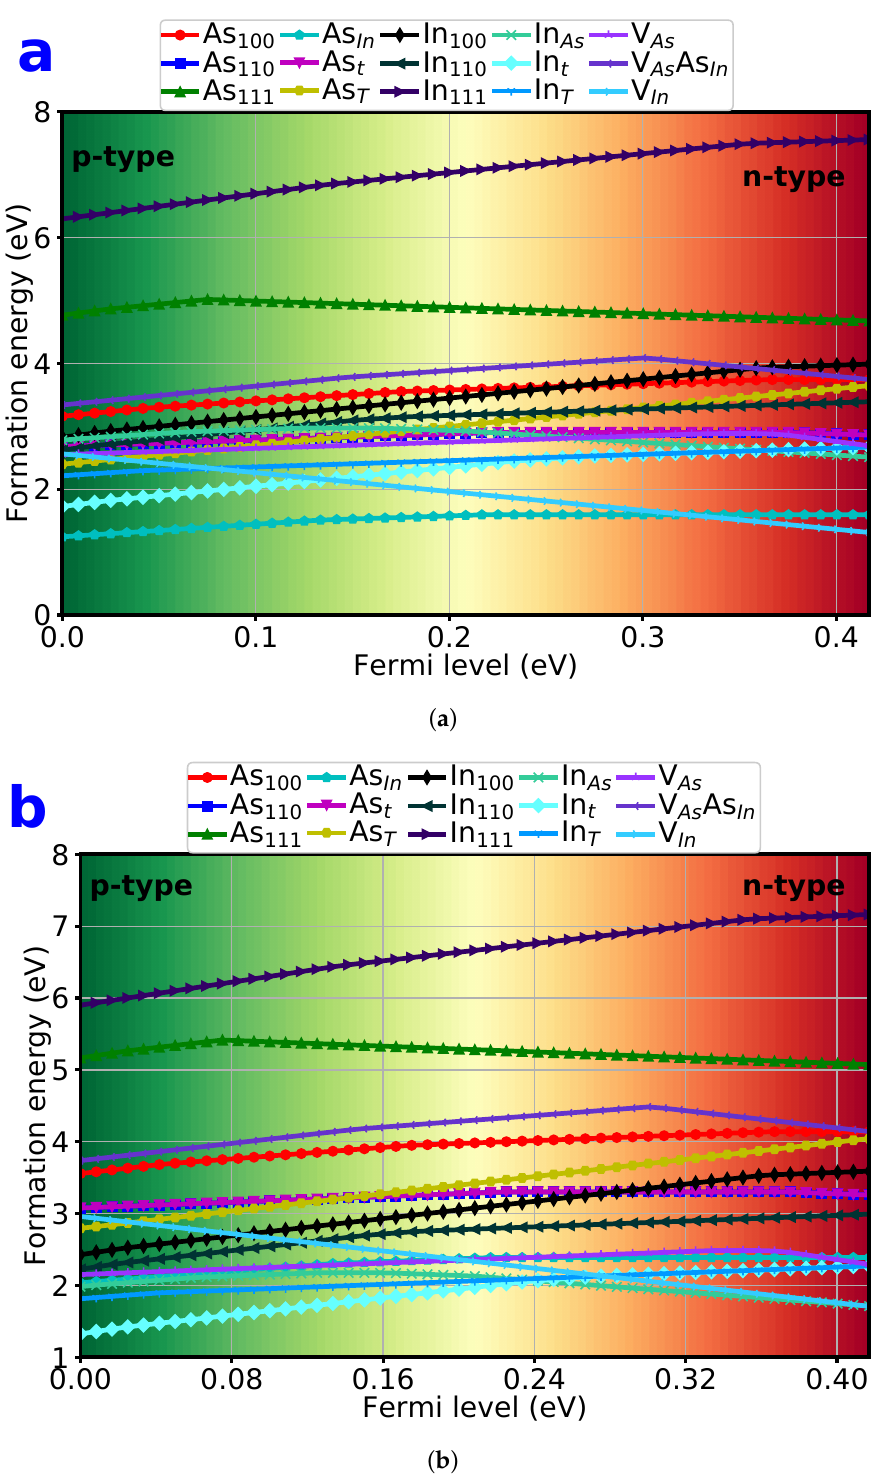
Figure 3. Formation energies as functions of E F in the As-rich ( a ) and In-rich ( b ) environments for fifteen different types of point defects in zb -InAs with all possible charge states from − 4 to +4 + e . The different doping regimes near valance bands ( p -type) and conduction bands ( n -type) are